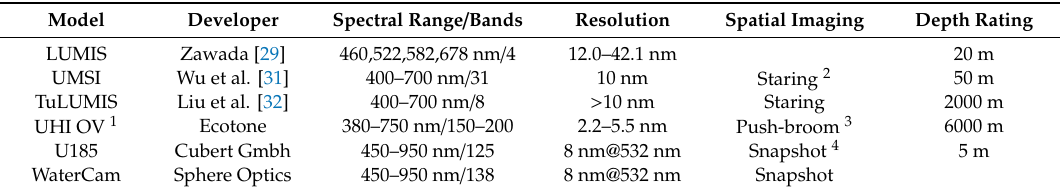
Table 1. Some of the underwater spectral imaging systems. LUMIS: low-light-level underwater multispectral imaging system; UMSI: underwater spectral imaging